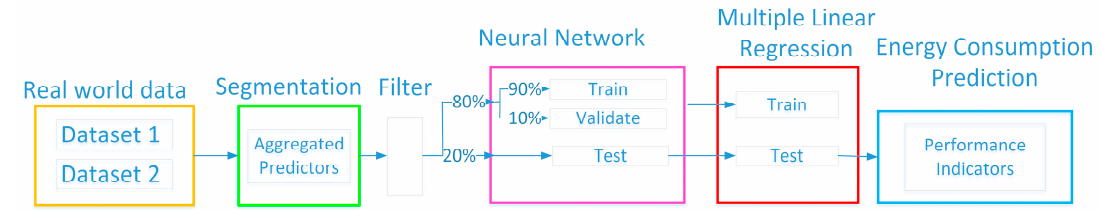
Figure 6. Overview of the data partition and data process flow for the proposed energy consumption prediction model.